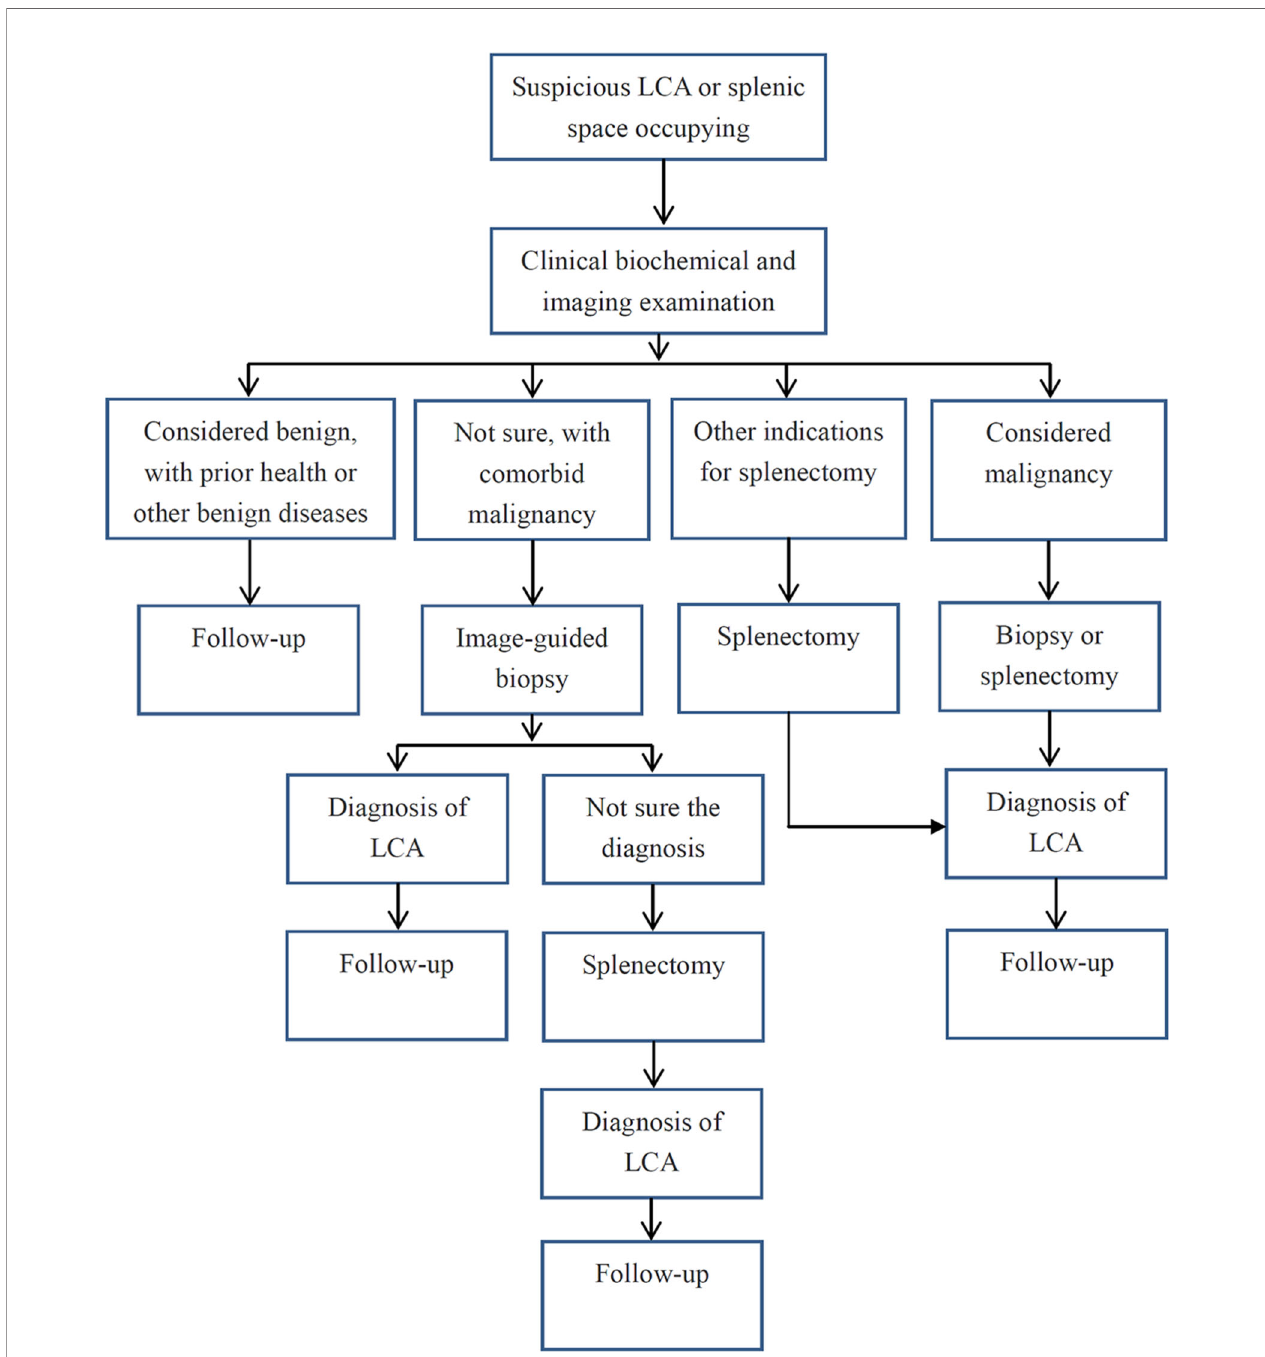
FIGURE 5 | A process of diagnosis and treatment for